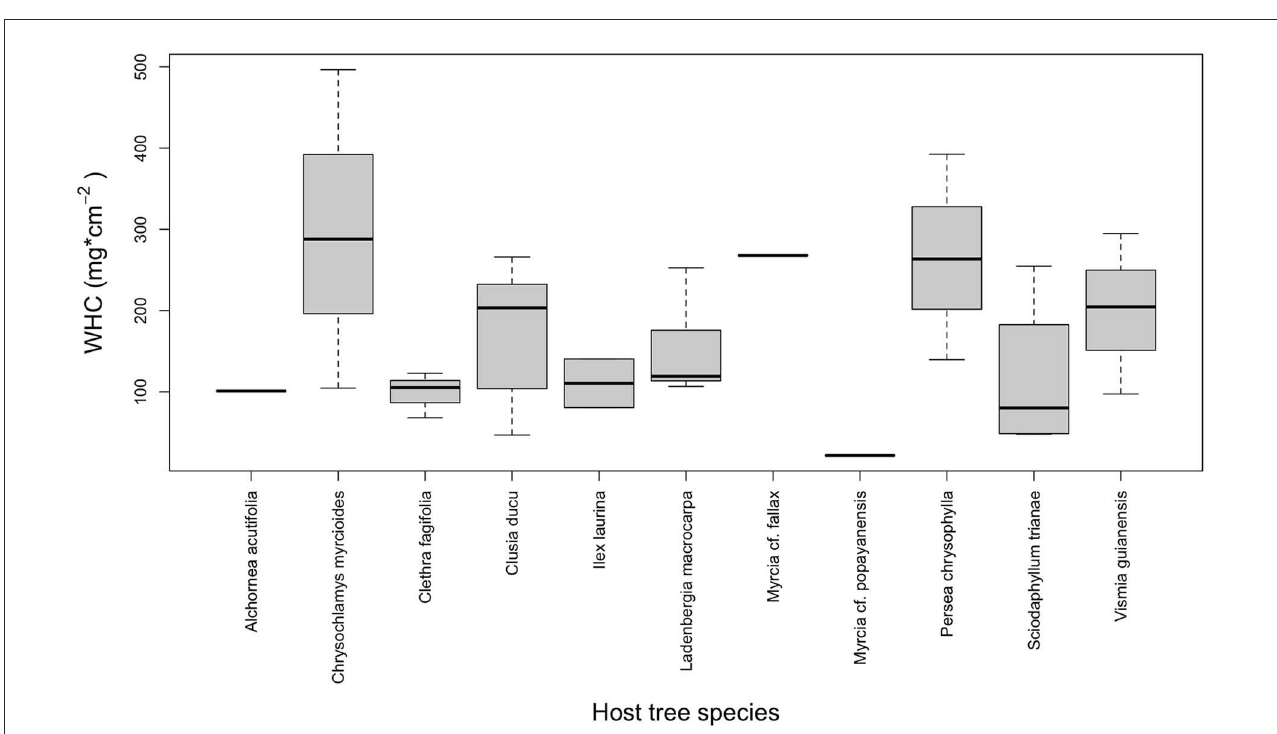
FIGURE2 Boxplot of water-holding capacity content (WHC) among host tree